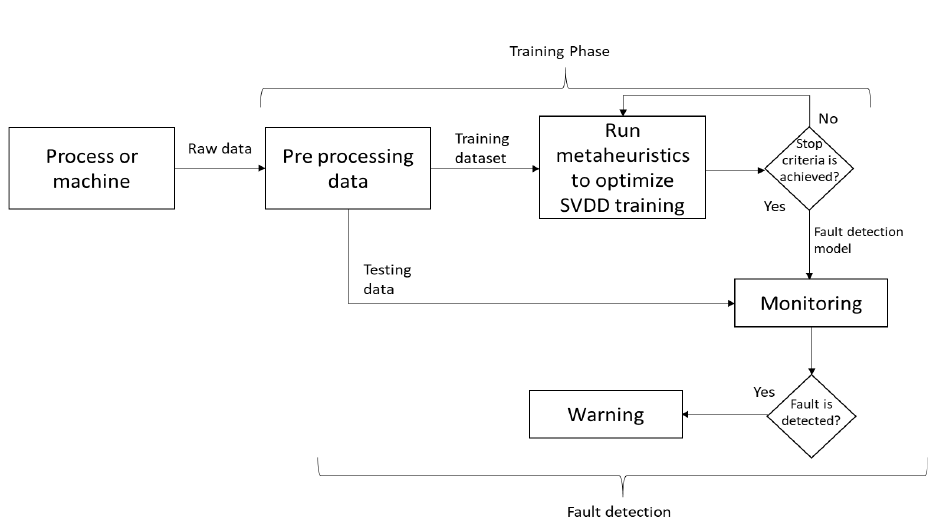
Figure 1. Fault detection